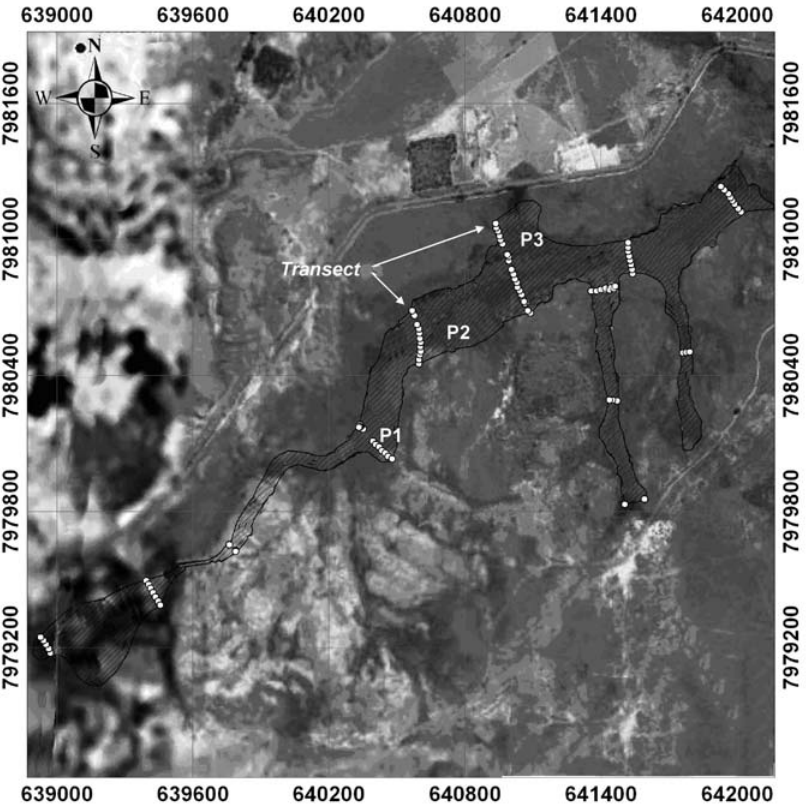
Figure 1. Location of sampled points in the transects and the profiles that were described and sampled in the peatland conservation unit Pau-de-Fruta, Diamantina –